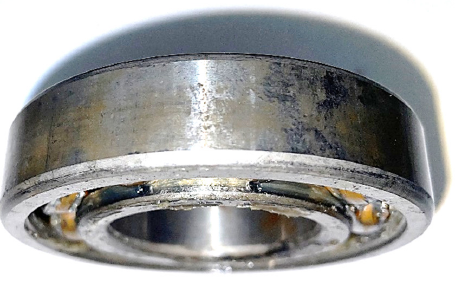
Figure 3. Corroded surface of a rolling bearing.